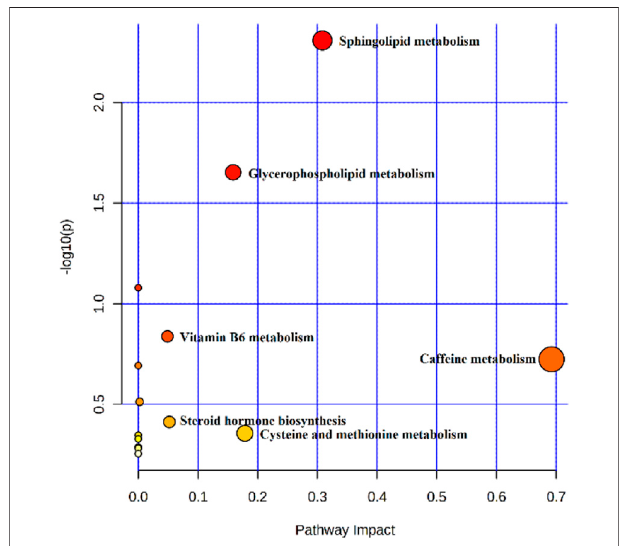
FIGURE 9 | Pathway analysis of plasma samples from BDS rats.